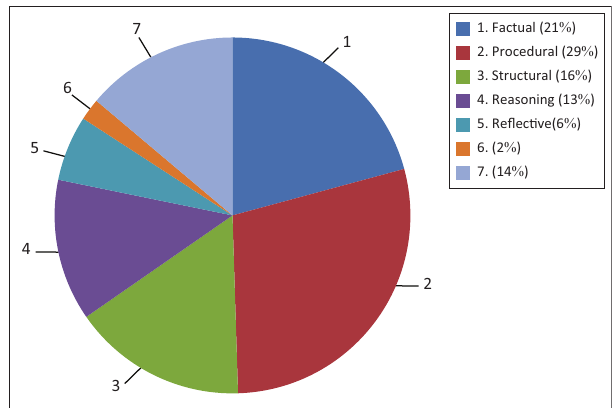
FIGURE 2: Composite percentage of questions as per question